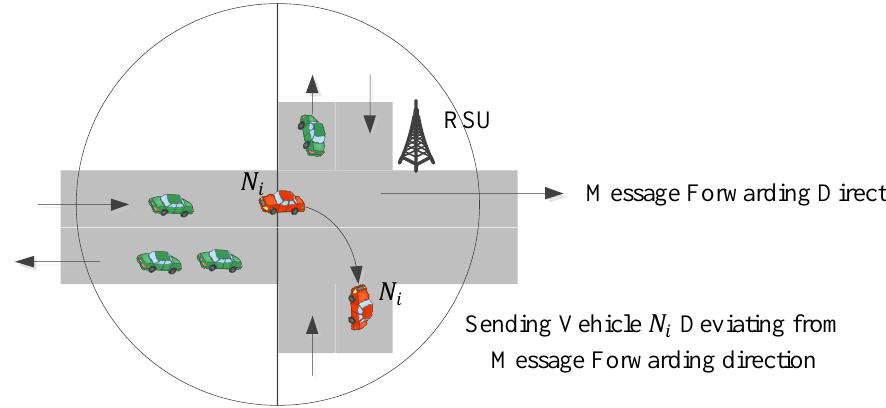
Figure 6. A sending vehicle deviation.